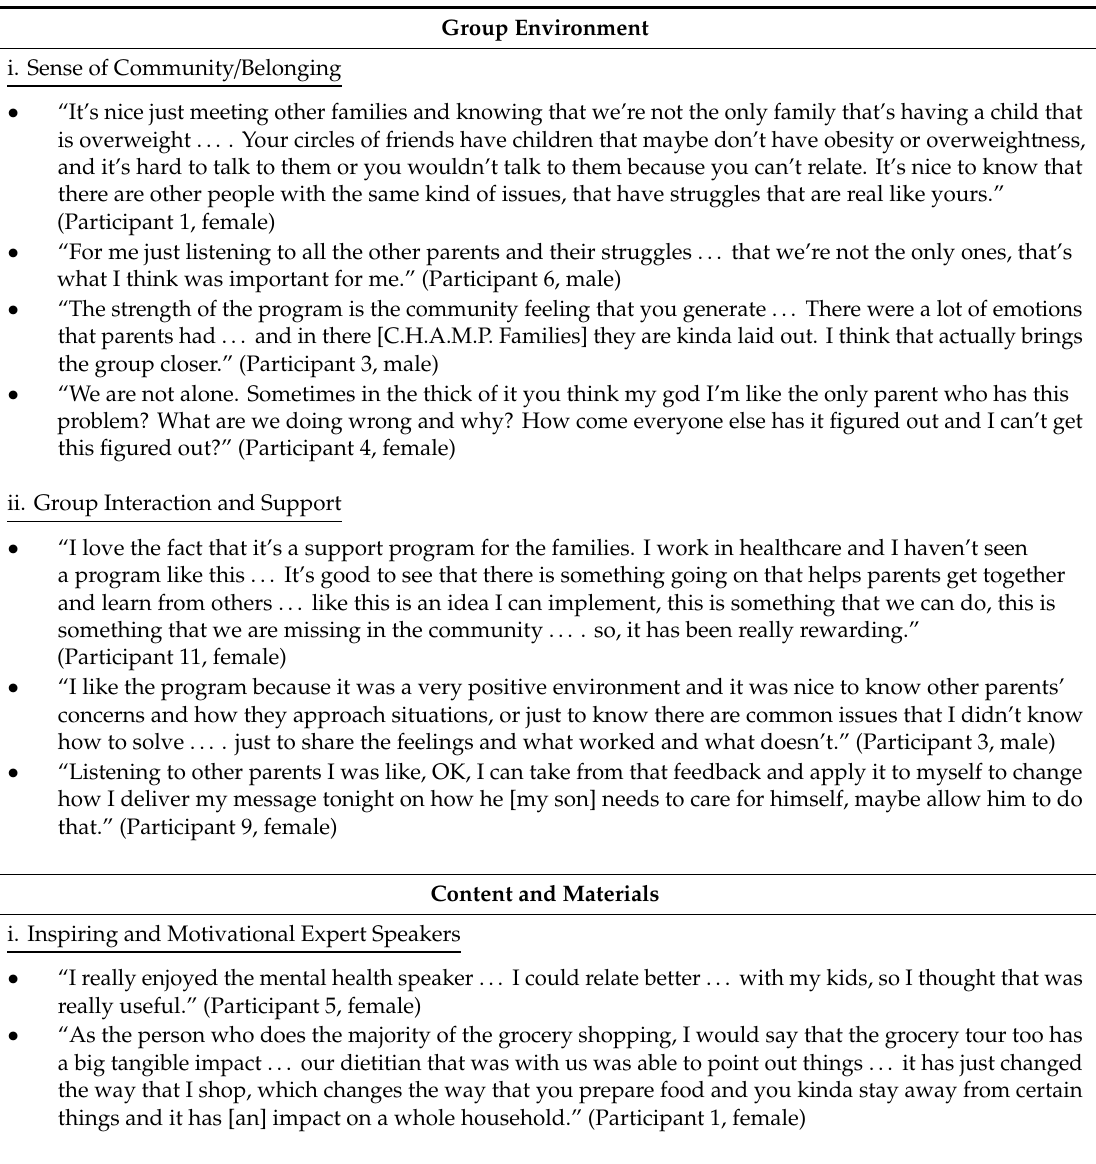
Selected quotes related to parents’ perceptions of impactful components of the C.H.A.M.P. Families